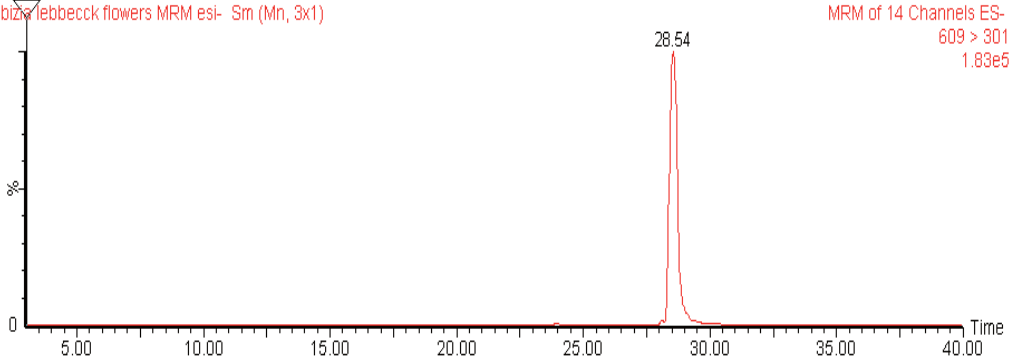
Fig. 2: MRM chromatogram of quercetin-rutinoside (609>301), identified through the loss of rutinosyl moiety (308 amu) and subsequent ionization of formed quercetin.